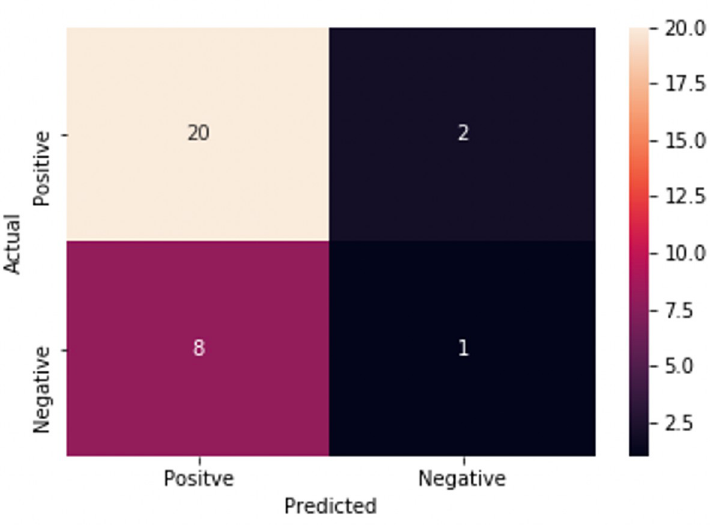
Fig 8. Confusion matrix from random forest classifier with heatmap indicator for added visualization. Starting from the top left corner, this square indicates the number of true positives. Moving clockwise, the next square is the false negative area, with the true negative square below it. The last square in the bottom left corner refers to the false positives.